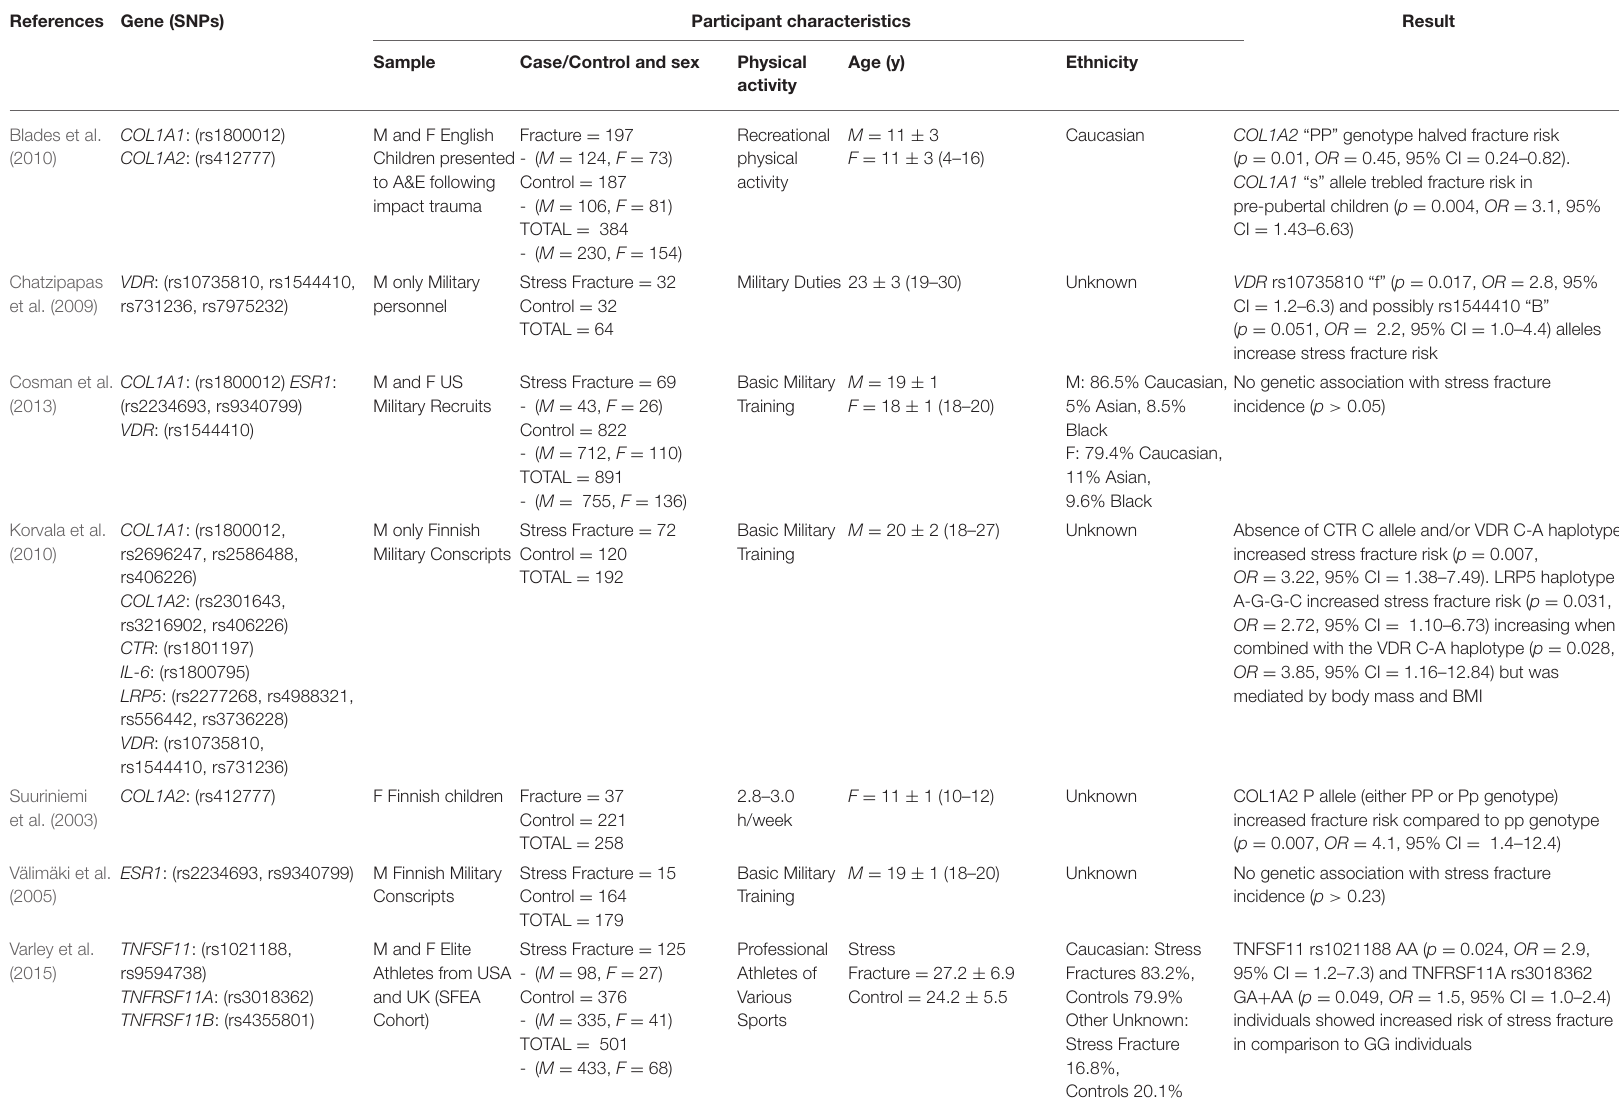
TABLE 1 | Summary of articles identified from systematic review of genetic case-control association studies with fracture risk in physically active